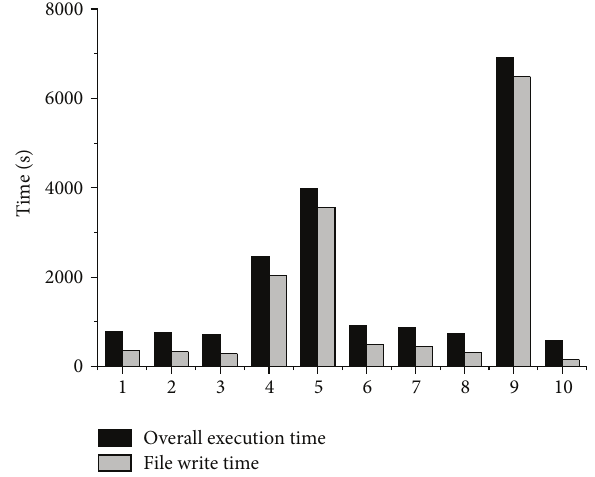
Figure 8: Theexecution timeof cavity runson Tianhe-2 for10